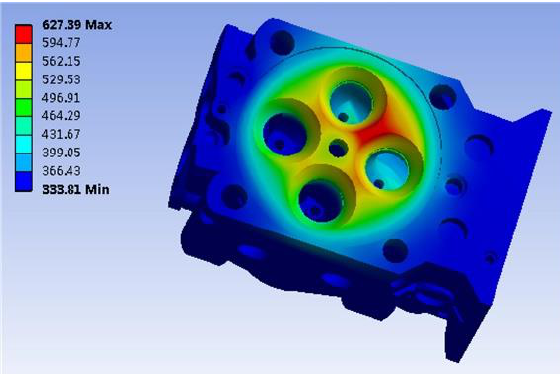
Figure 10. Contour map of the cylindrical head’s temperature field. Figure 10. C ontour map of the cylindrical head’s temperature field. Figure 10. C ontour map of the cylindrical head’s temperature field.